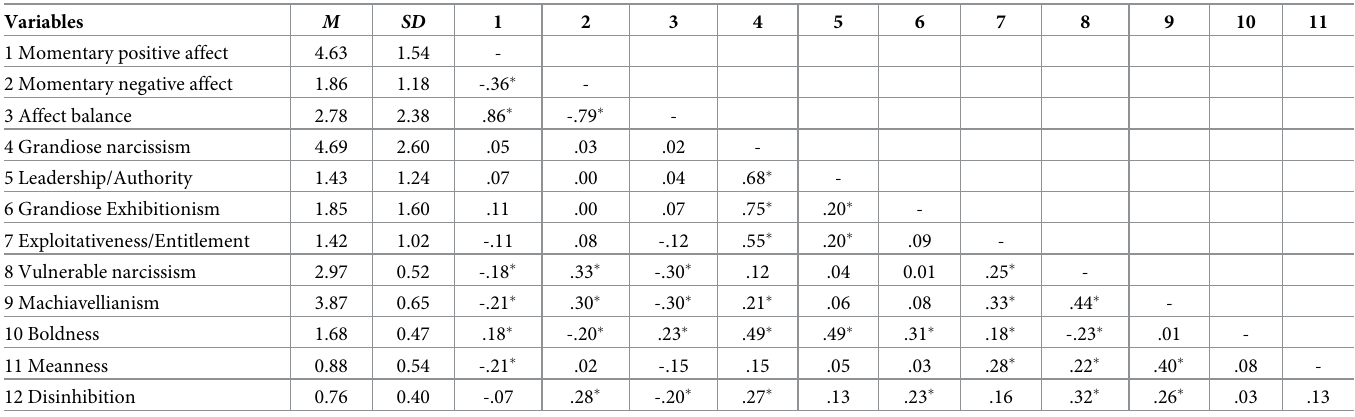
The momentary variables were aggregated before the analysis. Pearson’s correlation coefficient was used. N = 270 persons, n = 3047 measurements. � p < 0.0028 (two-tailed).